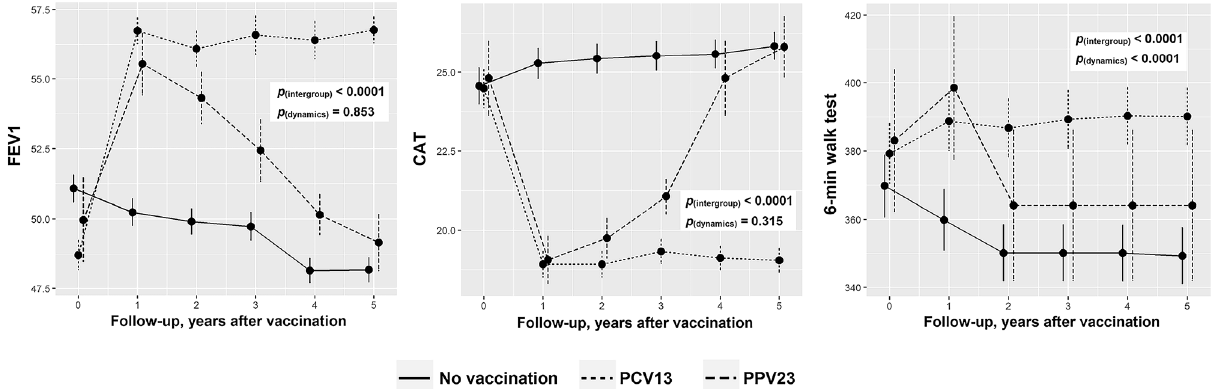
Figure 6. Dynamics of FEV1, CAT, and 6-min walk test in the study groups. The p value shows ANOVA statistics between